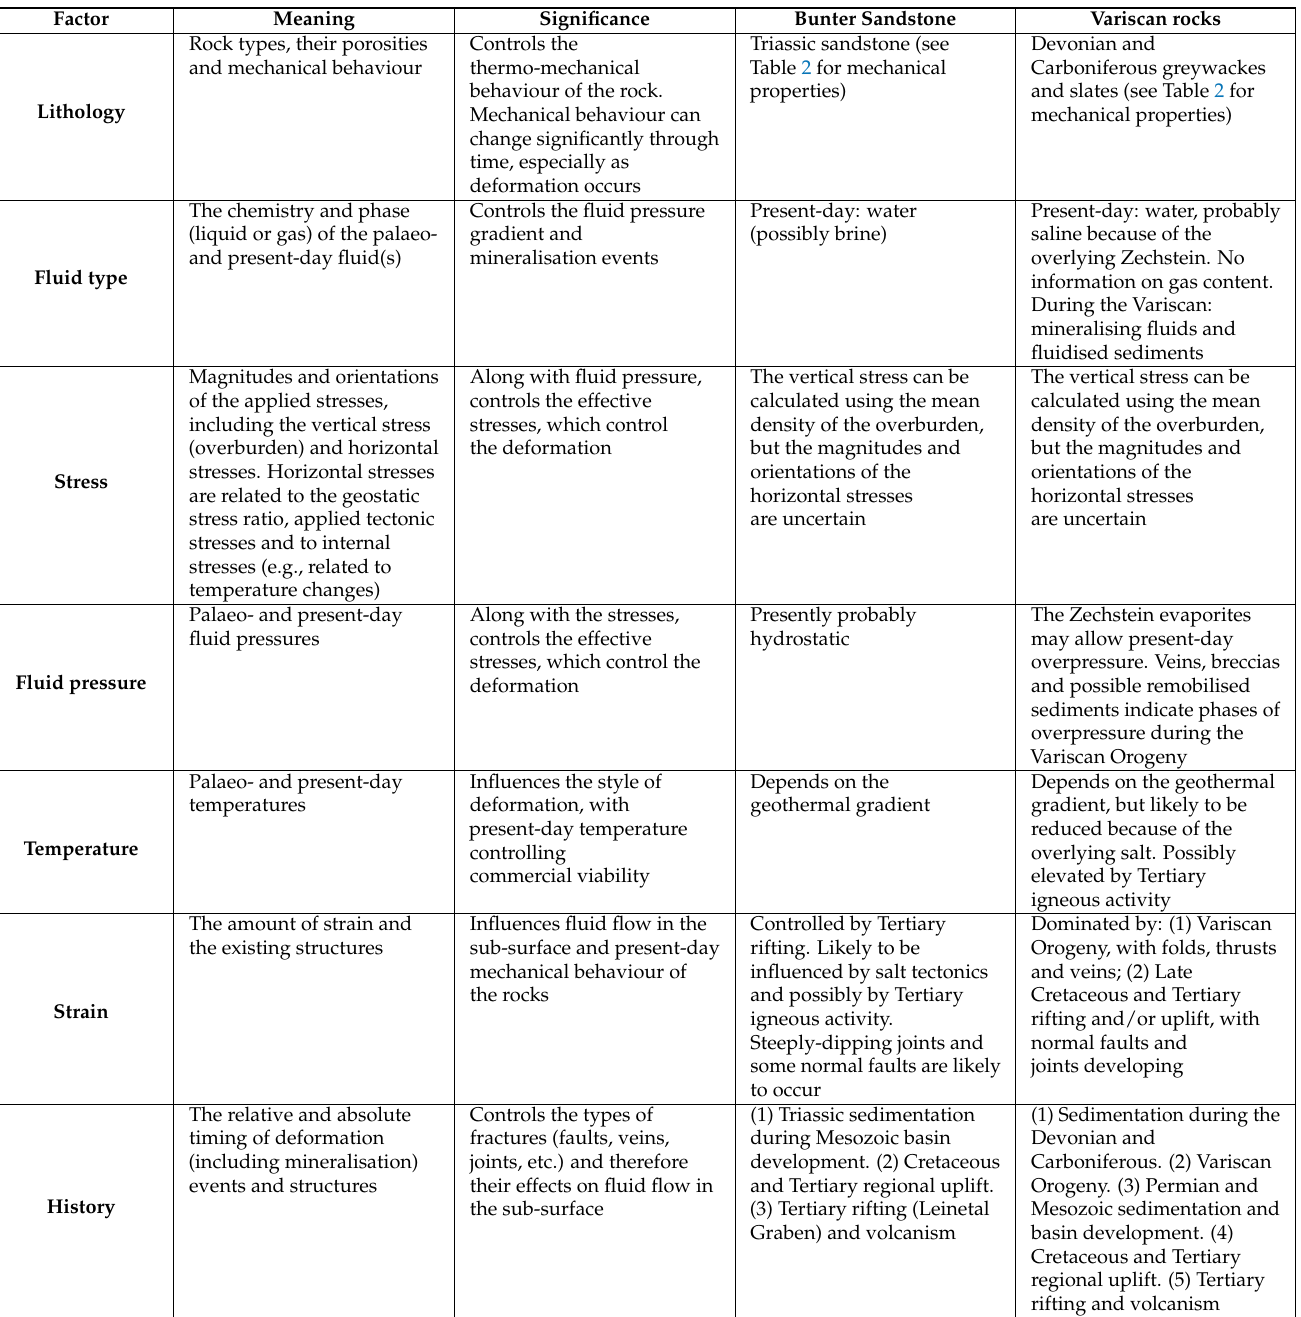
Table 1. Predictions about the geology of the potential geothermal reservoirs at Göttingen. See, for example, [38] for full information about deformation of the Bunter Sandstone in the Leinetal Graben. See [20,39] for further information about the geology of the Devonian and Carboniferous rocks of the Harz